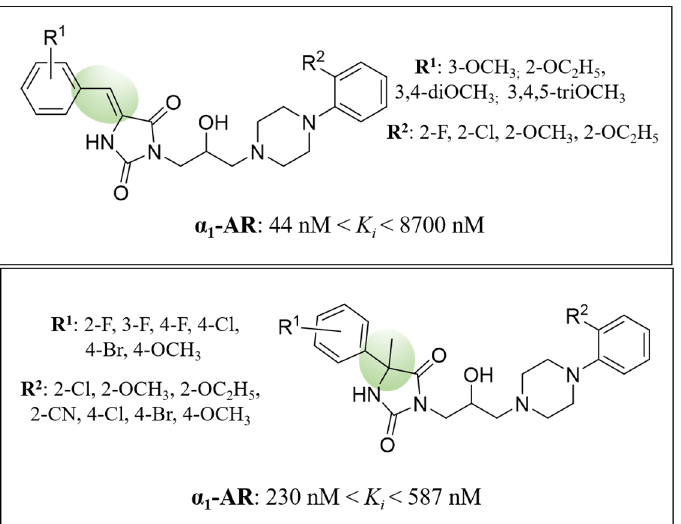
Figure 3. The structure and α 1 -AR affinities of the previously reported two groups of arylpiperazine derivatives of hydantoin.